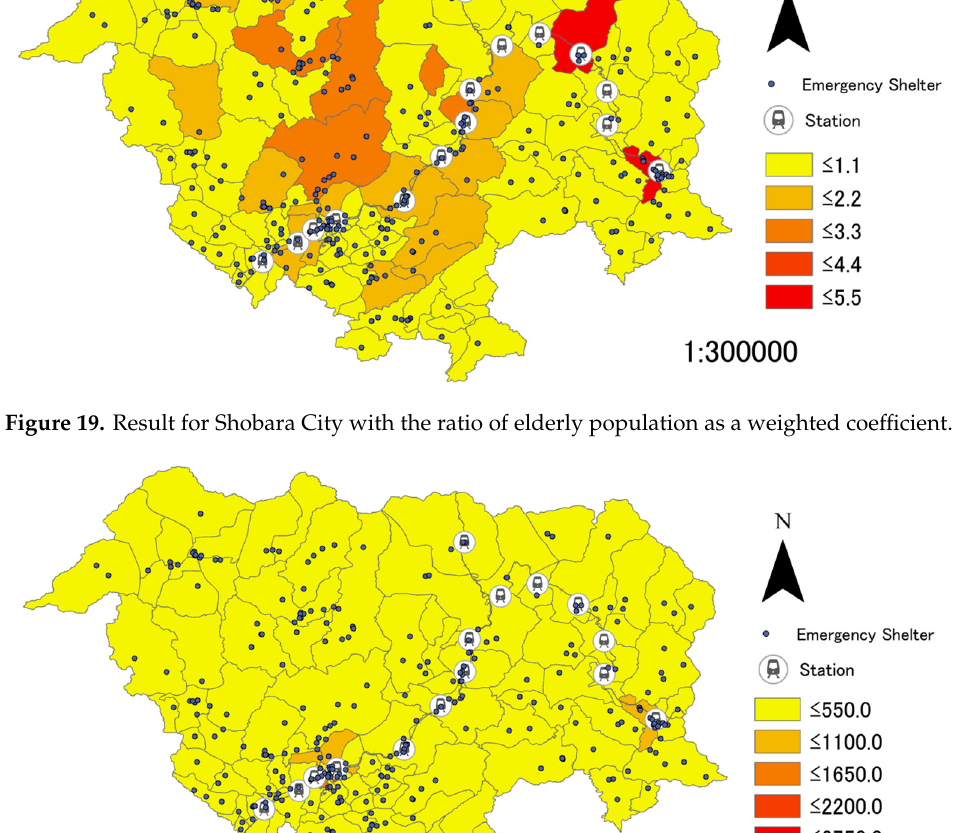
Figure 18. Result for Shobara City with the ratio of permanent population as a weighted coefficient.